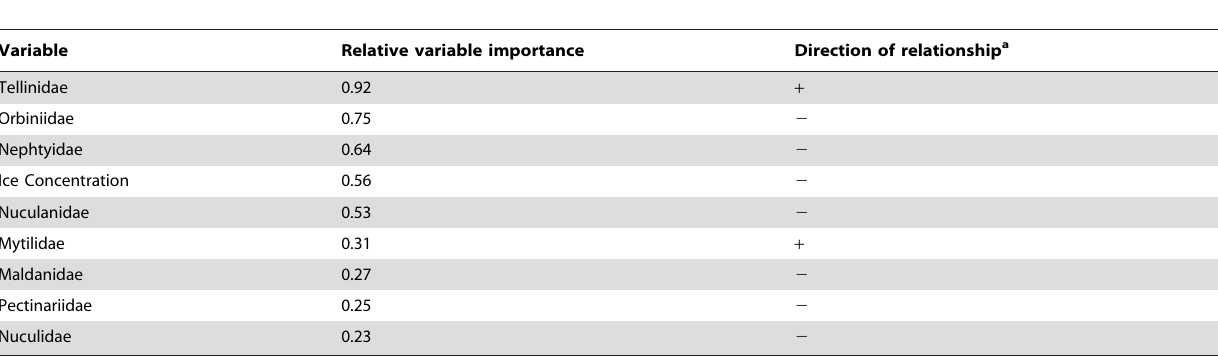
Table 3. Relative variable importance and direction of variable coefficients among 319 models fitted to estimate Pacific walrus resource selection in the northern Bering Sea.